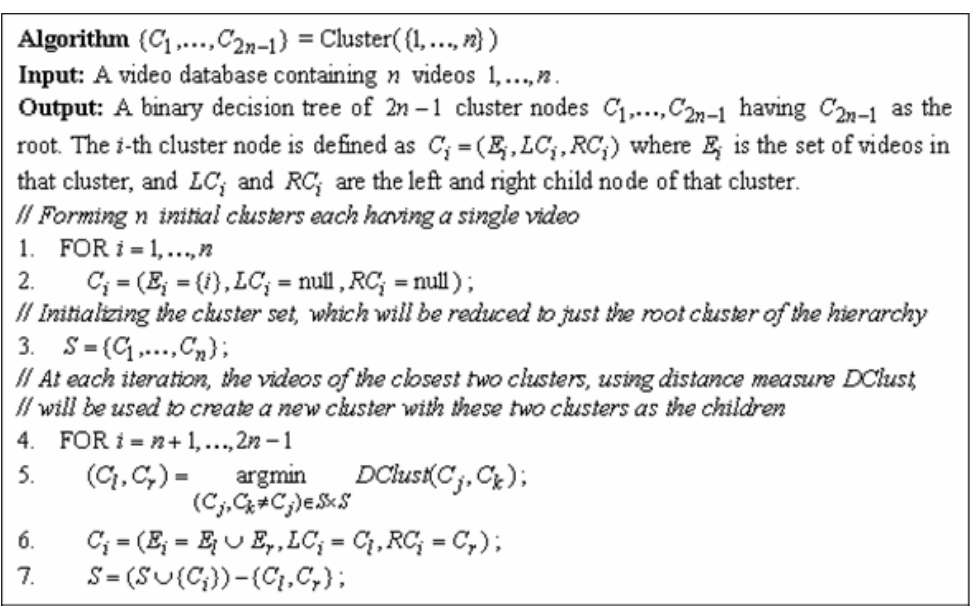
Fig 3: Cluster computation using hierarchical clustering